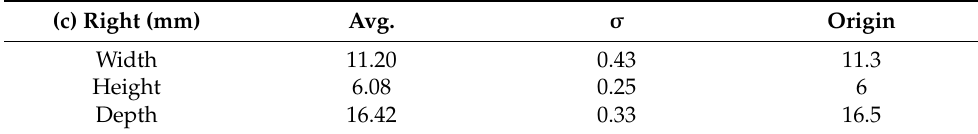
Table 4. Dimensions of the right part of the cage.